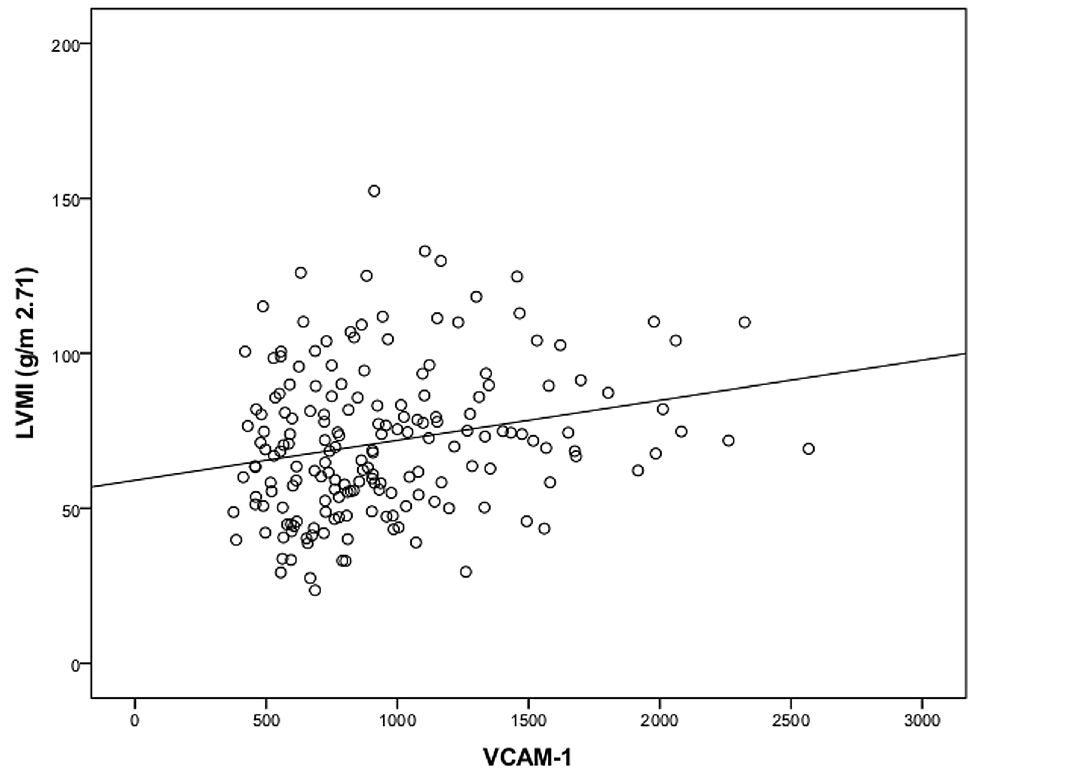
Fig 3. Correlation between VCAM-1 with left ventricular mass (g/m 2 (cid:1) 71 ) (n = 182).